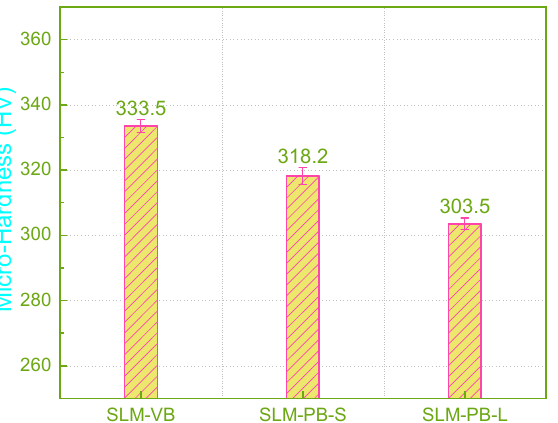
Figure 7. Micro-hardness values of samples.